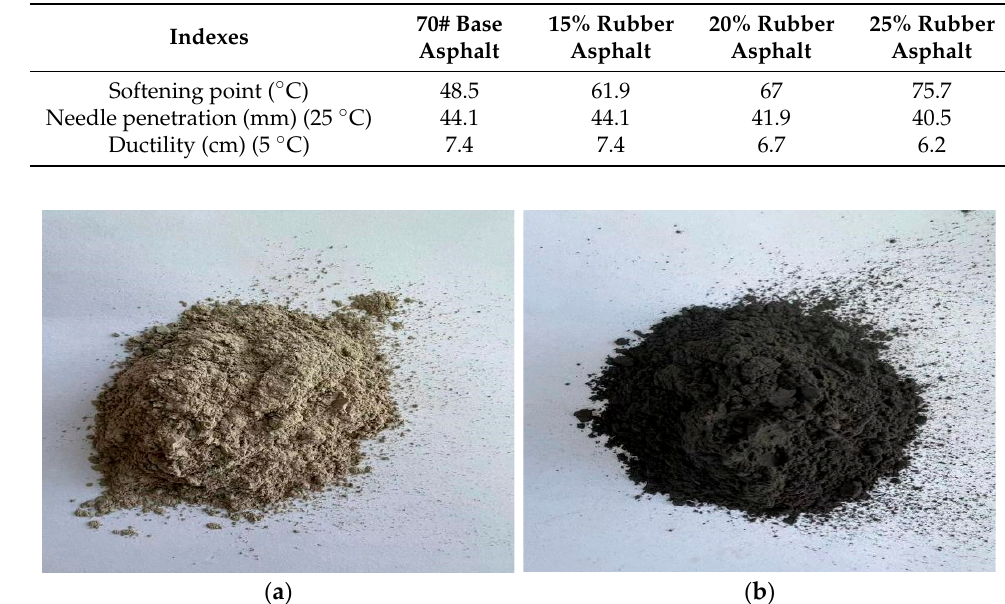
Table 1. Three leading indicators of asphalt.